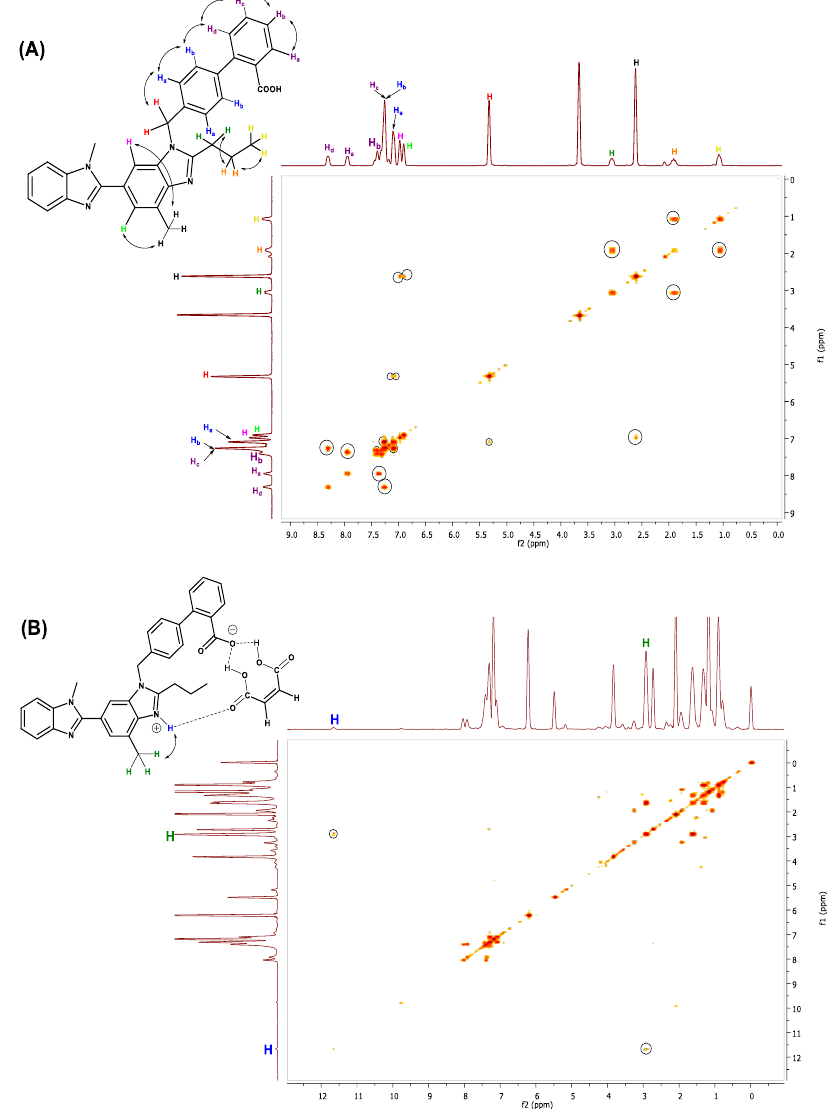
Figure 17. 1 H- 1 H COSY analysis of ( A ) Pure telmisartan. ( B ) Cocrystal. From the integration of the signals of the 1 H NMR of the cocrystal, it was evident that a 1:1 adduct formed in between the pure drug and the maleic acid. The analysis of the chemical shift values of the pure drug and the cocrystal in the 1 H NMR revealed that the protons in the aryl ring bearing the – COOH group are shielded by 0.5 – 0.6 ppm in the cocrystal in comparison to that of the pure drug. This could be only possible if the – COOH group losses its proton. Hence, we speculate that maleic acid would first pro- tonate the most basic N-centre of the drug molecule to form a 1:1 imidazolium maleate salt (Figure 18, structure A) which might undergo another proton exchange process from the carboxylic acid group of the drug to the maleate center (B). Overall, maleic acid is fa- cilitating the pure drug to attain a zwitter ionic form being stabilized by multiple H-bonding in between the zwitter ionic drug molecule and maleic acid (structure B).